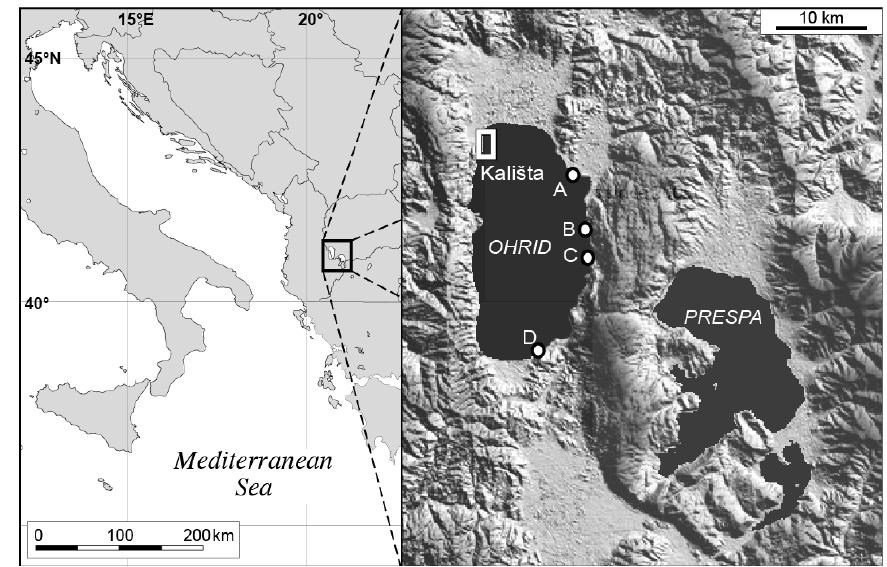
Fig. 1. Location and map of Lakes Ohrid and Prespa with site of the Kaliˇsta subaquatic springs in the northwestern corner of Lake Ohrid (white frame). Four white dots indicate locations of the other major subaquatic spring areas; A=Kaneo, B=Eleˇsec, C=Velidab, D=Sveti Naum.